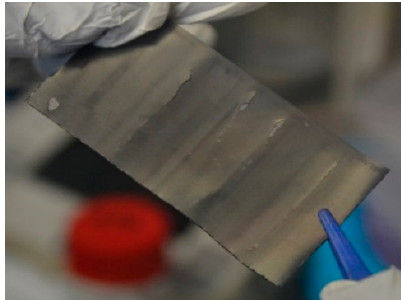
Figure A2. Sample harvested from the positive electrode of an aged cell. Pressure lines are clearly observed and there is an evident detachment of the active material from the current collector, especially at the pressure lines. A methodology and complete post-mortem analysis can be found in [40].